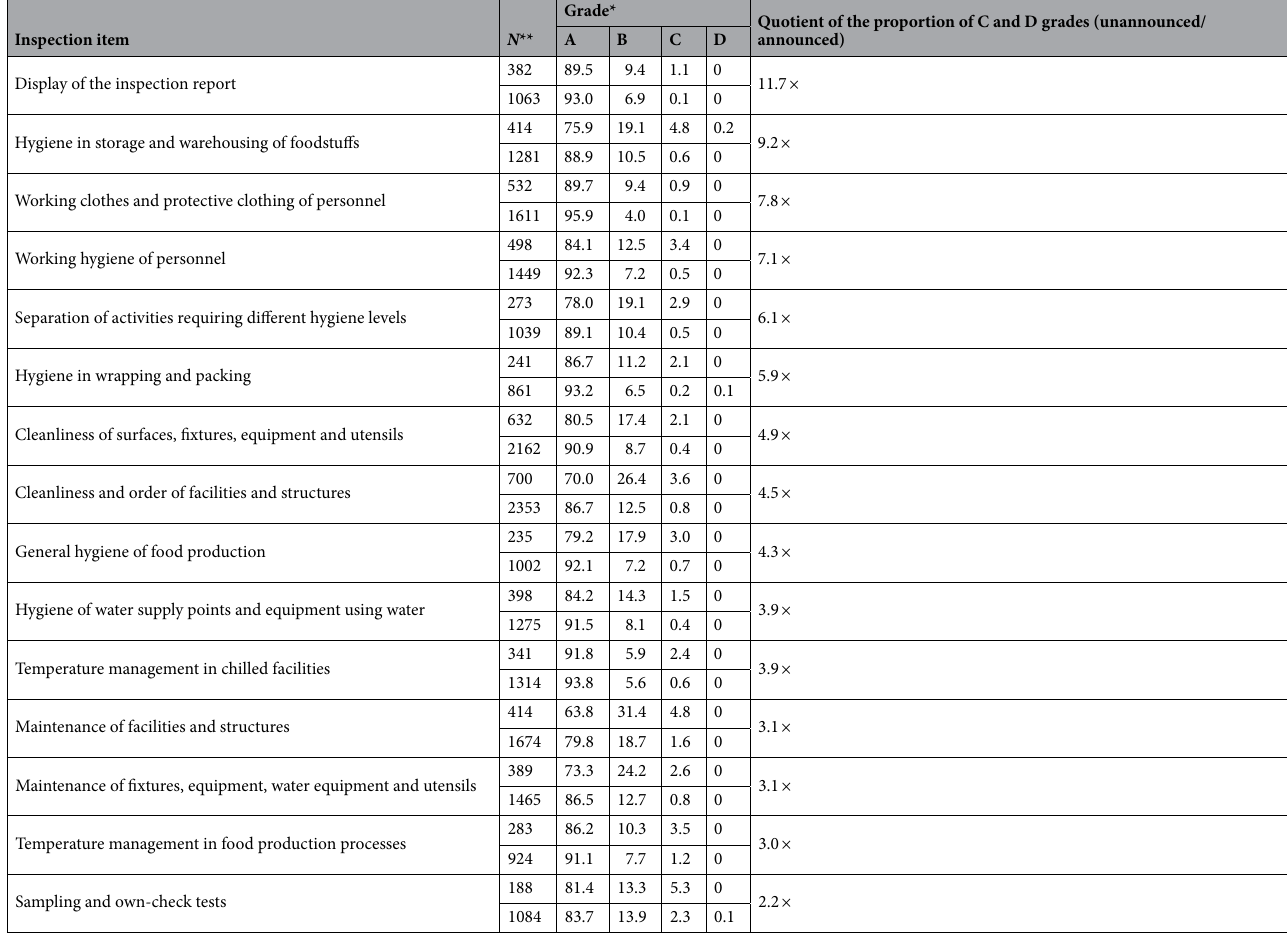
Table 2. Grade distribution of inspection items on unannounced (1st line) and pre-announced (2nd line) pre-planned inspections. * A = complies with requirements; B = minor issues that do not impair food safety